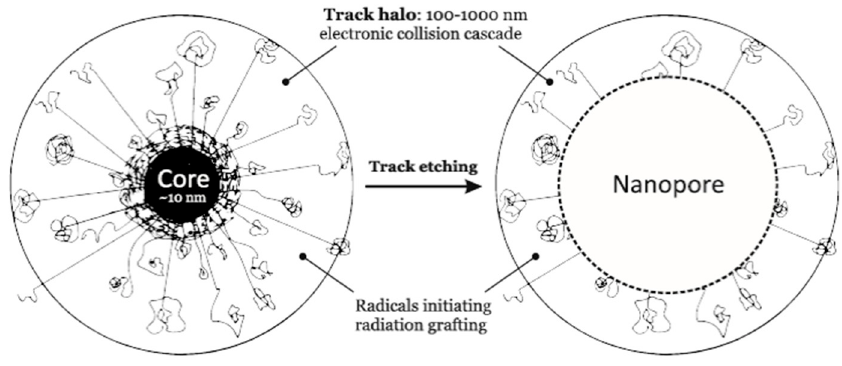
Figure 10. Schematic image of swift heavy ions (SHI) irradiated polymer film before and after etching.